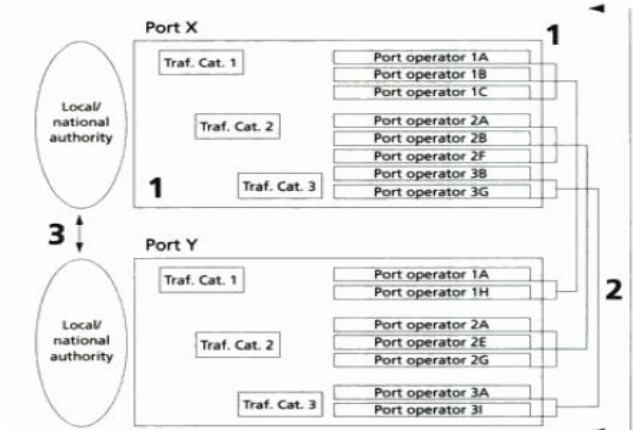
Figure 1: A visual depiction of the conceptual definition of seaport